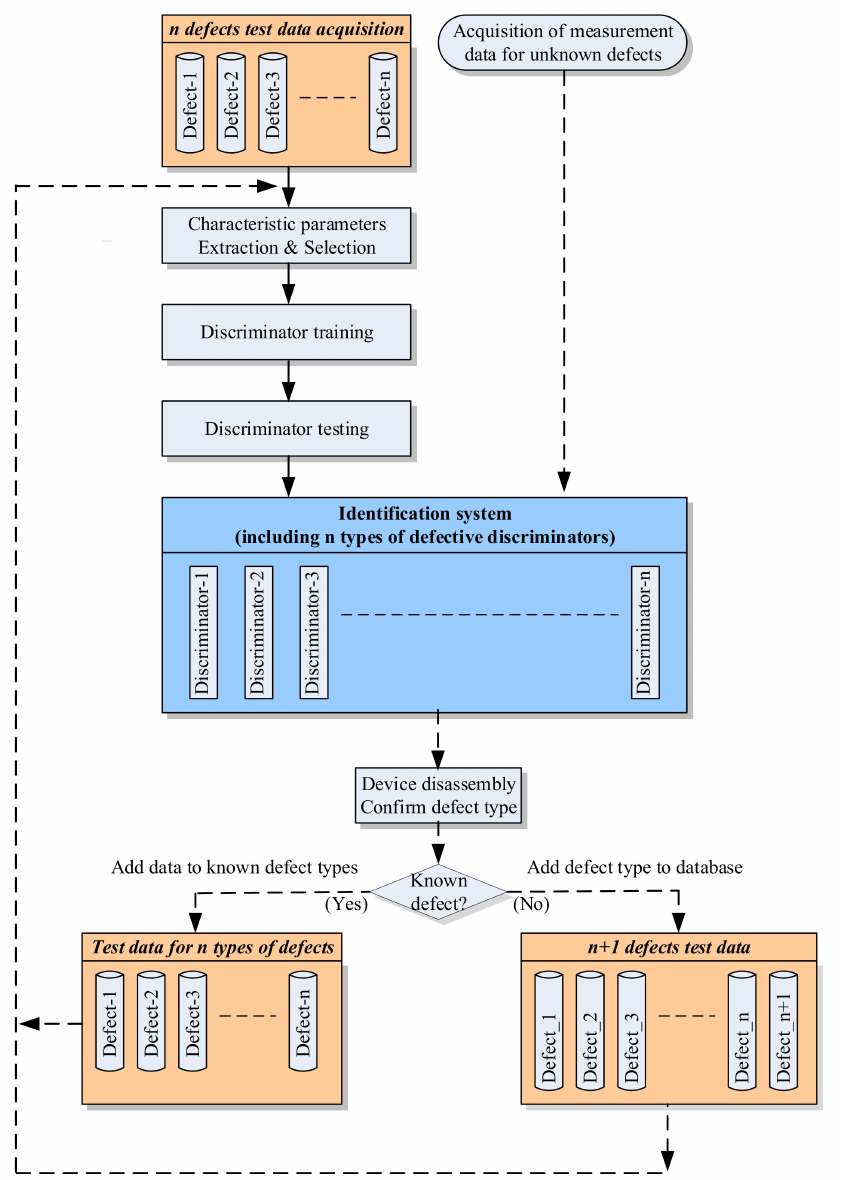
Figure 1. Schematic diagram of the construction of a defect measurement database.